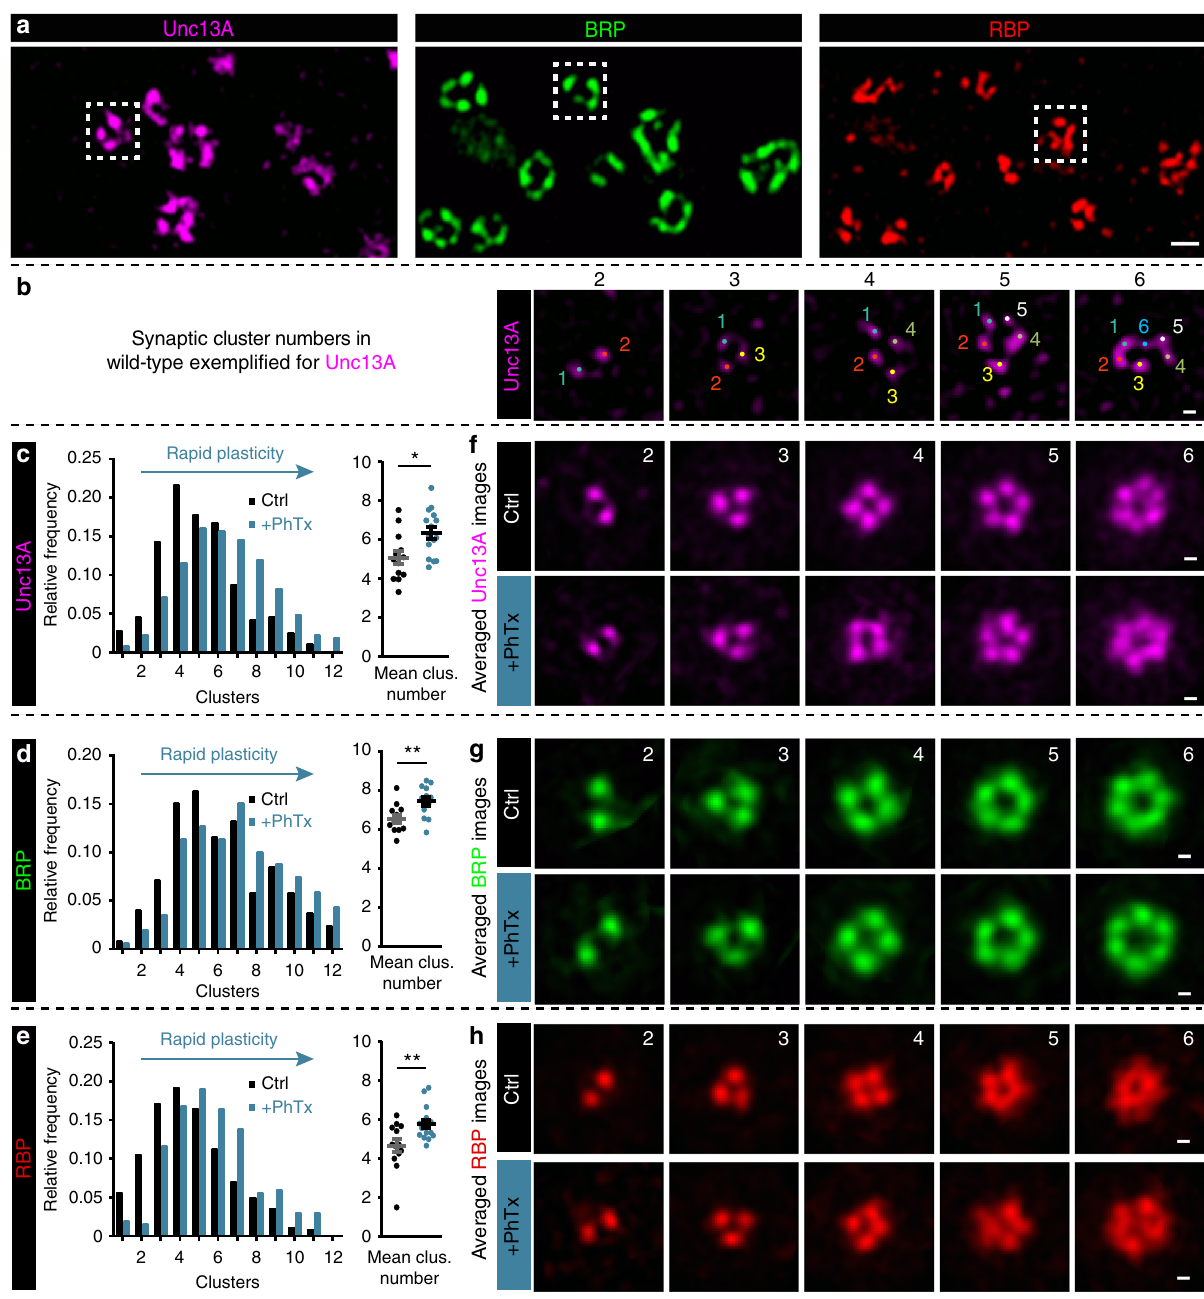
Fig. 2 Rapid plasticity alters Unc13A/BRP/RBP AZ protein cluster number. a STED microscopy images containing several AZs with variable numbers of protein clusters of Unc13A (magenta), BRP (green) and RBP (red). Dashed white boxes mark one AZ example used for the cluster number counting. b Example AZs with 2 – 6 Unc13A clusters, marked by colored dots and used for cluster number counting. ( c – e , left) Frequency distribution of Unc13A ( c ), BRP ( d ), and RBP ( e ) modules per AZ either without (Ctrl, − PhTx; black) or with PhTx ( + PhTx; blue) treatment. f – h Average of rotated STED images stained against Unc13A ( f ), BRP ( g ), and RBP ( h ) with 2 – 6 modules either without (Ctrl) or with PhTx ( + PhTx) treatment. See also Supplementary Figs. 2 – 4. Source data as exact values, detailed statistics including sample sizes and P values are provided in the Source Data fi le. Scale bars: a 200 nm; ( b , f – h ) 50 nm. Statistics: Mann-Whitney U test. * P ≤ 0.05; ** P ≤ 0.01. Panels ( c – e ) show NMJ-wise means of AZ-mean ±